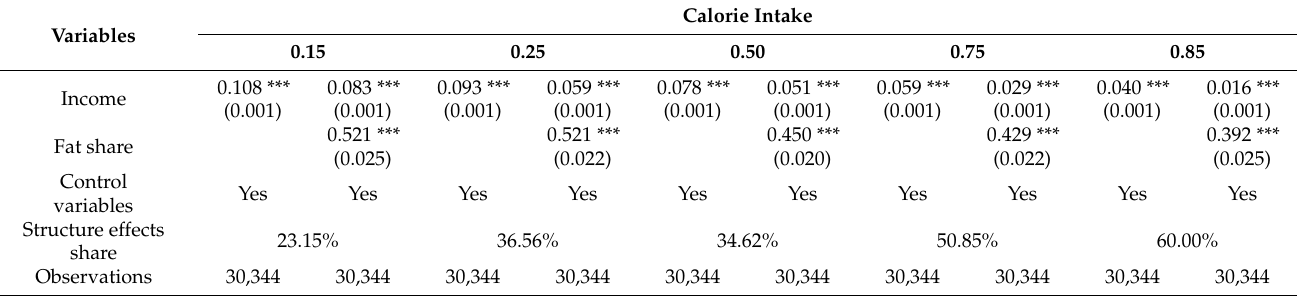
Table 3. IVQR estimates of the effect of income on calorie